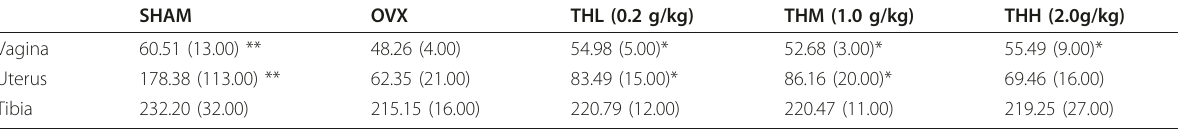
SHAM = Sham-operated control rats; OVX = ovariectomised non-honey treated control rats. THL = Tualang Honey, low dose; THM = Tualang Honey, medium dose; THH = Tualang Honey, high dose. All values are expressed as the median (IR). a Kruskal - Wallis test.